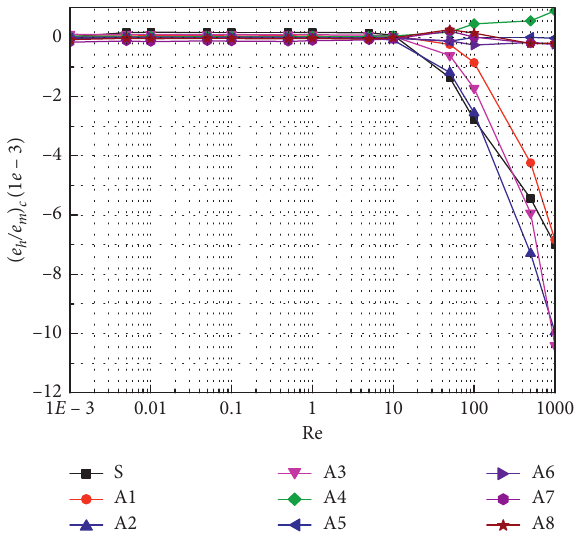
Figure 5: Variation of the difference of relative hydraulic aperture e ) ( e h / m C with Reynolds number under different decomposition levels in the approximate profile